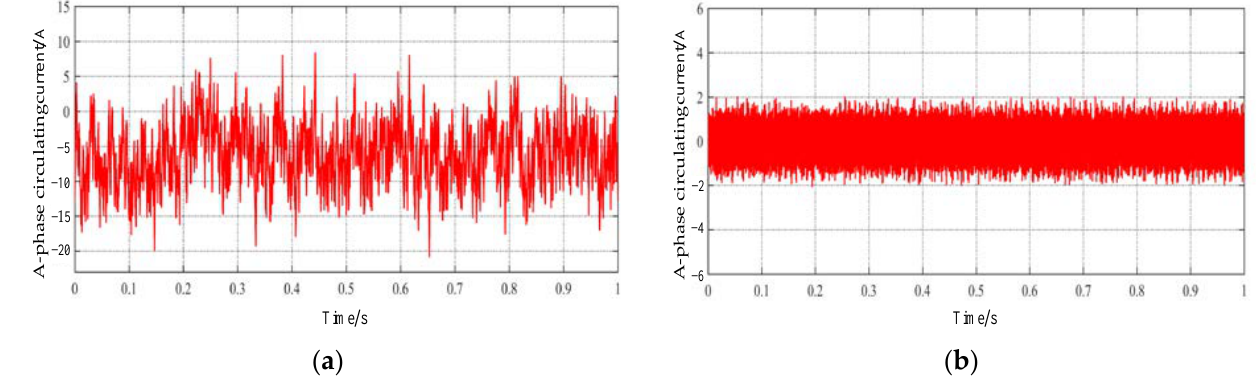
Figure 10. ( a ) A-phase circulation without current equalization loop. ( b ) A-phase circulation when joining the current equalizing ring.